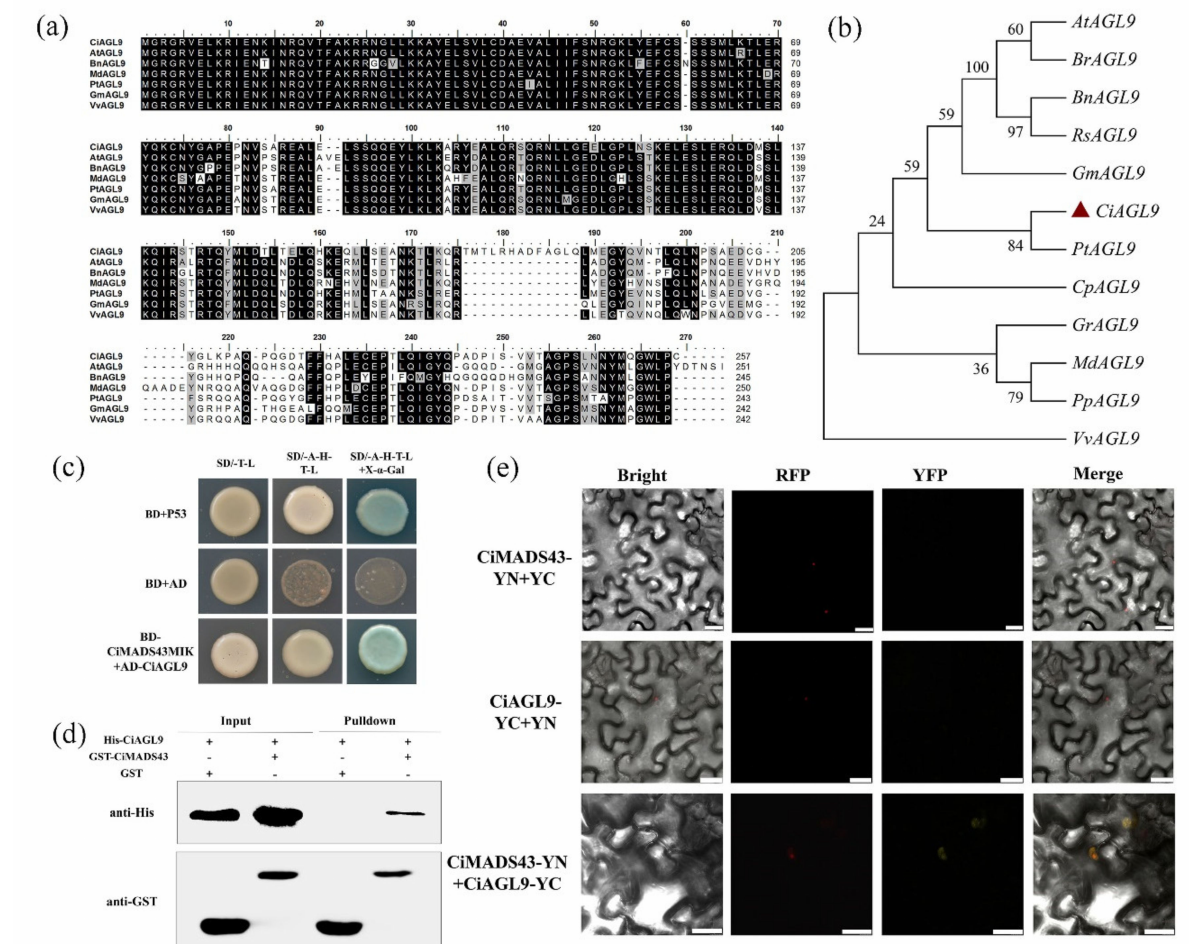
Figure 4. The interaction between CiAGL9 and CiMADS43 protein. ( a ) Multiple sequence alignment of CiAGL9 protein and its homolog proteins. CiAGL9, Citrus sinensis (NP_001306995.1). AtAGL9, Arabidopsis (AAC00586.1). BnAGL9, Brassica napus (XP_022545908.1). MdAGL9, Malus domestica (XP_028952174.1). PtAGL9, Populus trichocarpa (XP_024453001.1). GmAGL9, Glycine max (NP_001242742.2). VvAGL9, Vitis vinifera (NP_001268114.1). ( b ) Phylogenetic analysis of AGL9 proteins of citrus and other plants. The protein ID of all AGL9 proteins were listed in Table S1. ( c ) Y2H assays between CiMADS43MIK and CiAGL9 proteins. ( d ) Pull-down assay of the interaction between CiMADS43 and CiAGL9. ( e ) Bimolecular fluorescence complementation (BiFC) analysis of protein interactions between CiMADS43 and CiAGL9 in tobacco leaf epidermis cells. CiMADS43-YN + CiAGL9-YC, coexpression of 35S::CiMADS43-nYFP and 35S::CiAGL9-cYFP. CiMADS43-YN + YC and CiAGL9-YC + YN were used as the negative control. Scale bar = 25 µ